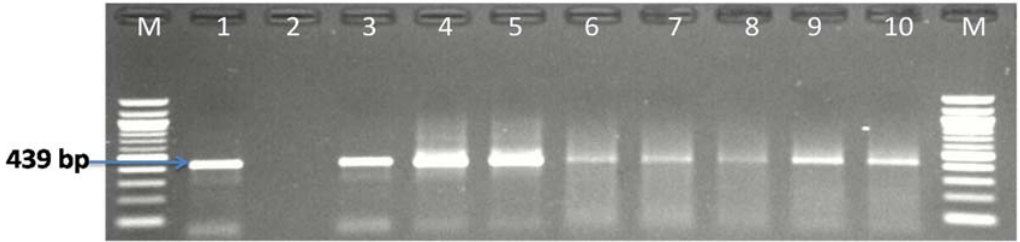
Figure 2. A representative gel image of PCR confirmed genus Campylobacter . Lane M: (100 bp DNA ladder), lane 1: positive control ( C. jejuni ATCC 3356), lane 2: negative control, lane 3–10: some positive Campylobacter isolates.